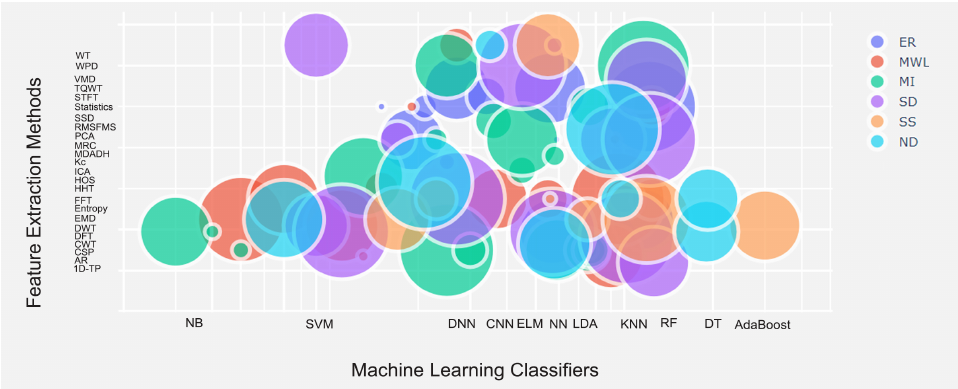
Figure 9. Bubble plot of studies according to classification algorithms and feature extraction methods. The size of the bubble indicates the performance of classification models for each task as marked with different